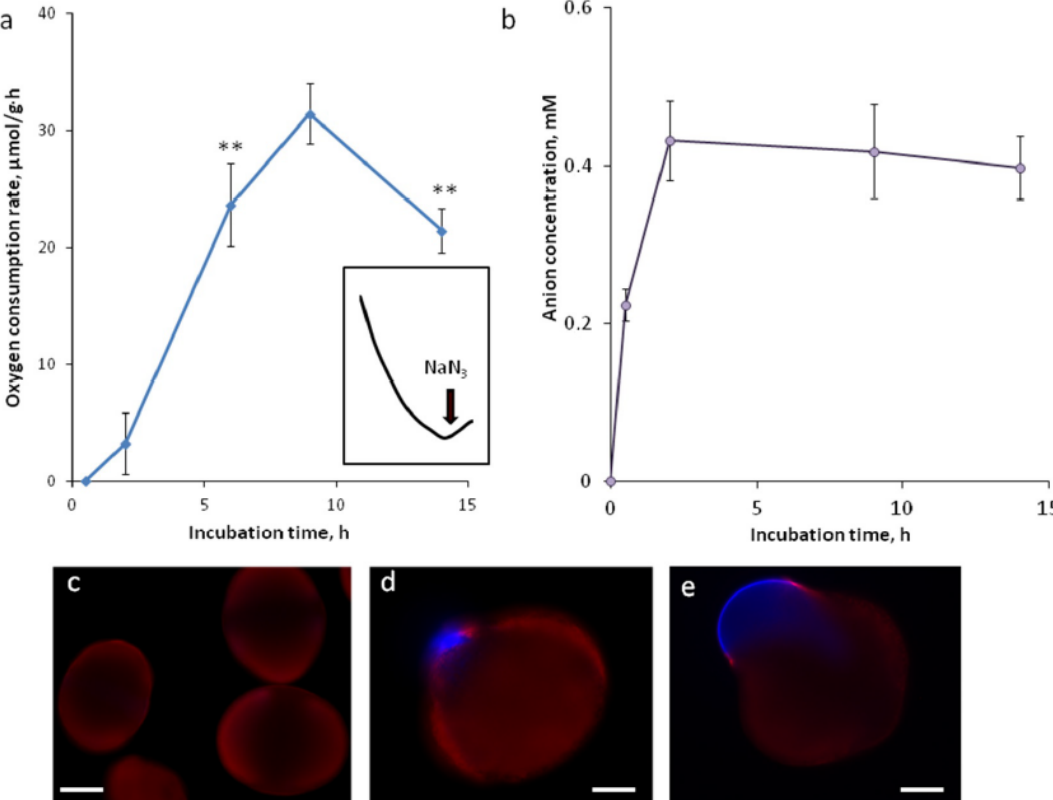
Figure 1. Dynamics of respiration and anion e ffl ux during pollen activation in spruce. ( a ) Oxygen consumption rate measured by polarography in spruce pollen suspension (2 mg / mL), inset—typical respiration curve (9 h) after the addition of sodium azide; ( b ) anions released by pollen into the germination medium detected by MEQ fluorescence quenching; ( c – e ) typical pollen grains stained with wall-binding dyes Tinopal (intine, blue) and MitoSOX (exine, red) after 2 ( c ), 6 ( d ) and 9 ( e ) h of incubation. ** p < 0.01; * p < 0.05. Bar: 40 ( c ) and 20 µm ( d,e ).